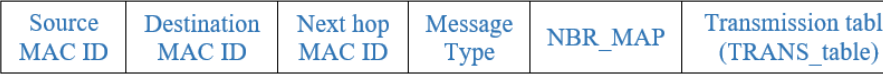
Figure 4. Format of request and acknowledgment control packets.